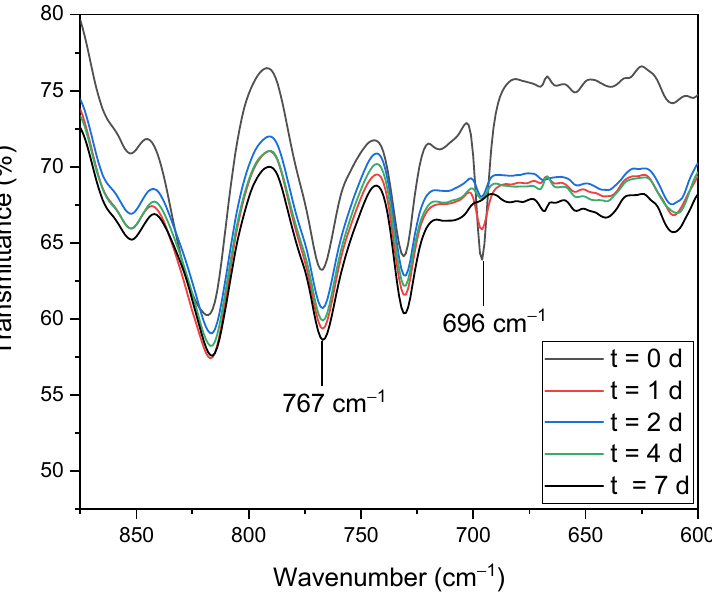
Figure 8. Decrease of the ring deformation mode of the maleimide group at 696 cm − 1 over a time period of 7 days.